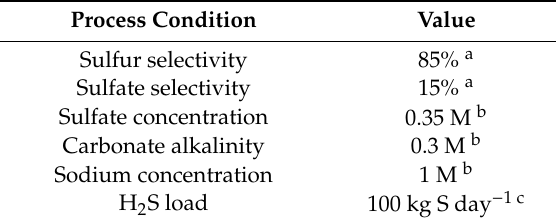
Table 1. Process conditions for a typical BD facility.